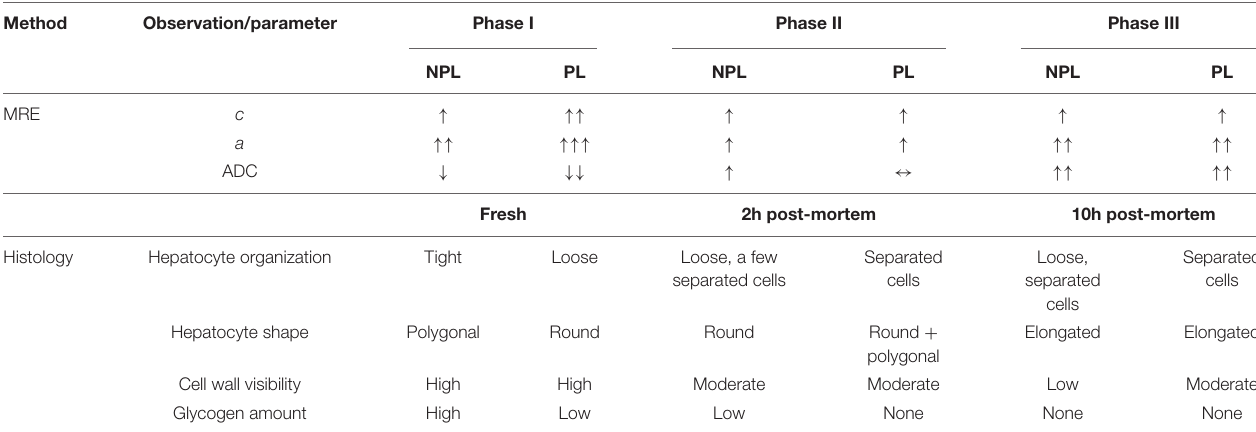
TABLE 2 | Main results of MRE, DWI and histological analysis in both non-perfused liver (NPL) and perfused liver (PL) samples at different phases and time points after